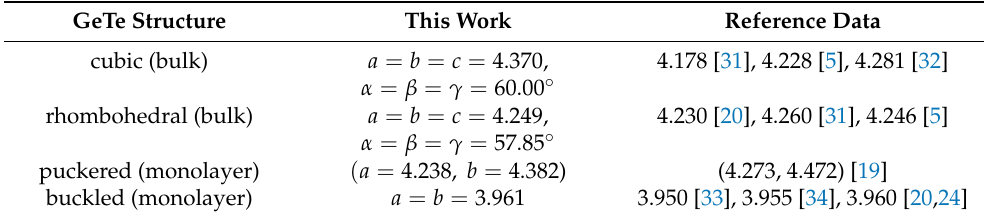
Figure 1. Lattice structures of ( a ) bulk and ( b ) monolayer GeTe. Bulk GeTe consists of cubic and rhombohedral lattices, while monolayer GeTe consists of puckered and buckled honeycomb lattices. The structural models are visualized by using VESTA [30]. Table 1. Lattice constants (in Å) of bulk and monolayer GeTe. The lattice constants ( a , b , c ) and angles ( α , β , γ ) are in accordance to the illustrations in Figure